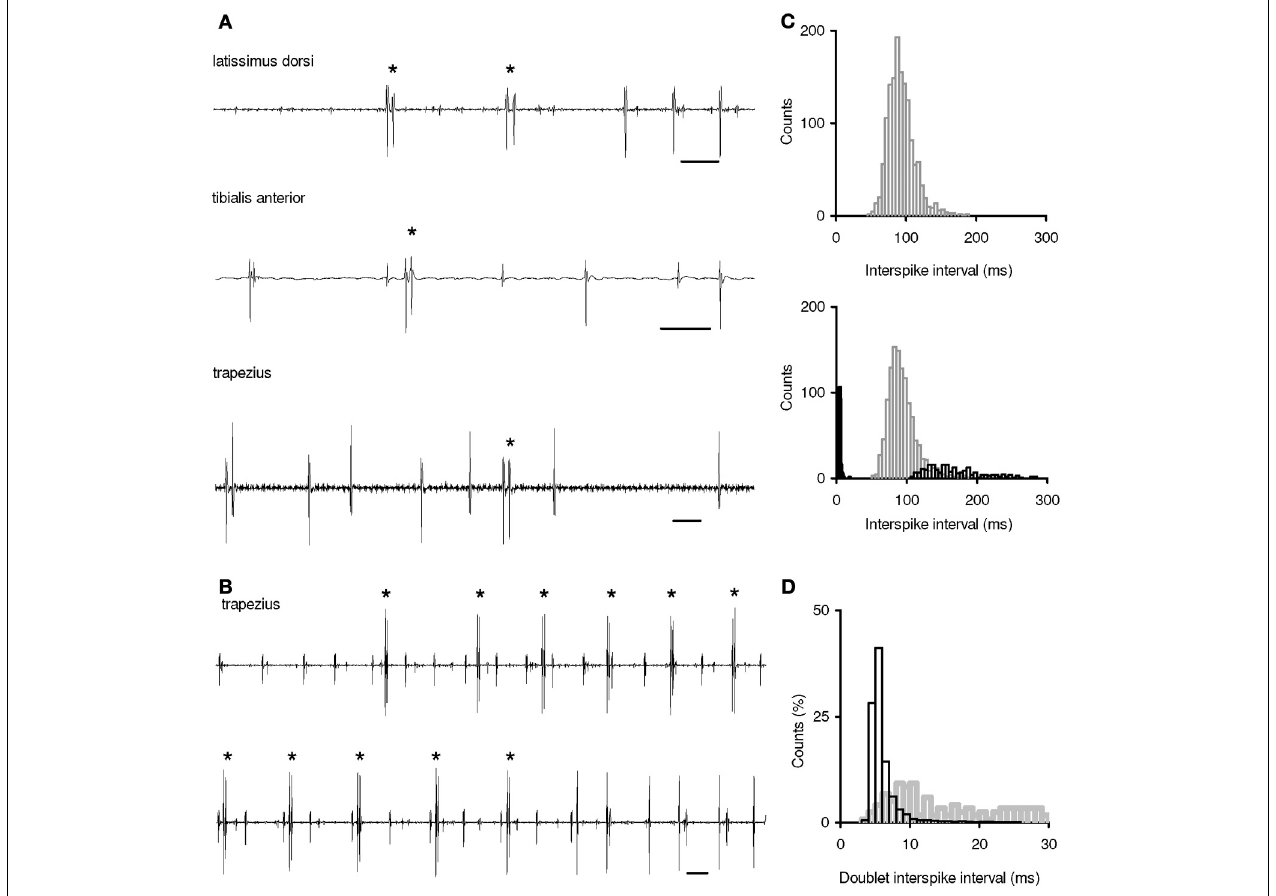
FIGURE 1 | Doublet firing in human motoneurons during voluntary muscle contractions. (A) Examples of MU single doublets. Top, two initial doublets at MU recruitment; middle, a doublet among single-spike firing; bottom, a doublet at MU de-recruitment. (B) Examples of repetitive doublets at MU recruitment (two records of MU potentials are in succession). Doublets are marked by asterisks. Time bar: 50ms. (C) Interspike interval (ISI) distributions of two trapezius MUs from the same experiment. Top, an MU displaying only single-spike firing ( n = 1 , 418).